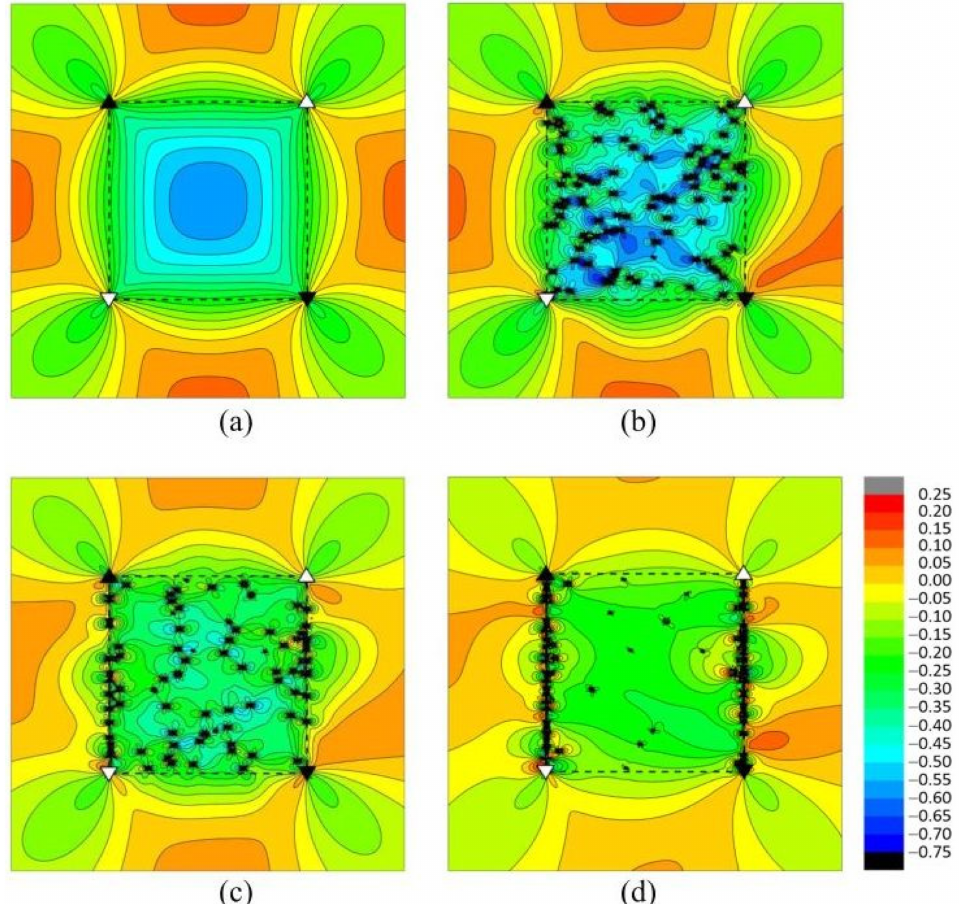
Figure 18. Maps of the shear stress-field component σ xy inside and outside the model grain: ( a ) disclination quadrupole without lattice dislocations; ( b ) initial disordered system of 100 dis- locations and disclination quadrupole before the ultrasonic action; ( c ) the same system after 100 and ( d ) 600 oscillation periods. The dashed line shows the square-shaped cross section of the grain. Black triangles indicate positive wedge disclinations, white ones negative wedge disclinations. Stresses are expressed in dimensionless units